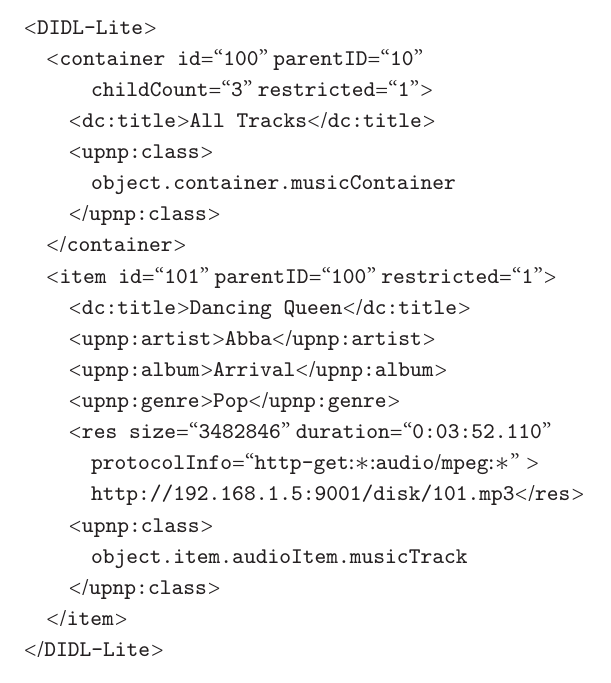
Algorithm 1: An example media item description.